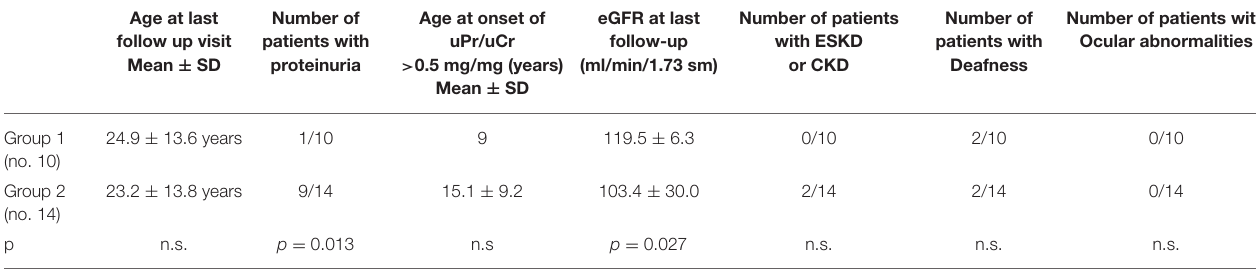
Number of patients with proteinuria